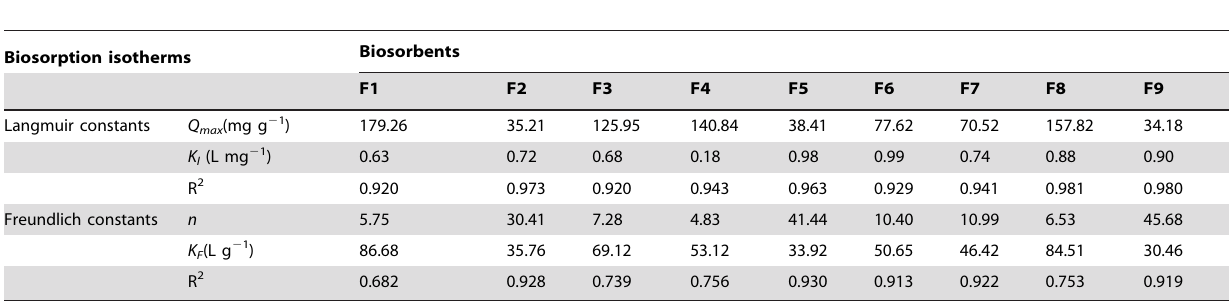
Table 2. The Biosorption isotherm parameters for the biosorption of Reactive Black 5 onto biosorbents.